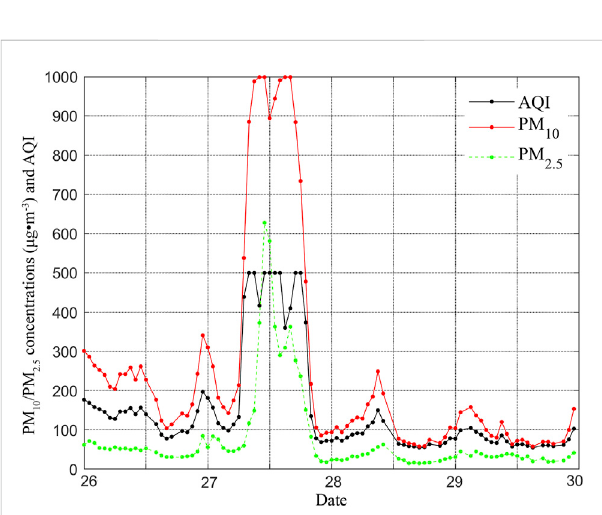
FIGURE 4 Temporal variation of the AQI and particulate mass concentrations in Urumqi during April 26 – 29, 2015. The black, red, and green lines represent the AQI, PM 10 concentration, and PM 2.5 concentration,